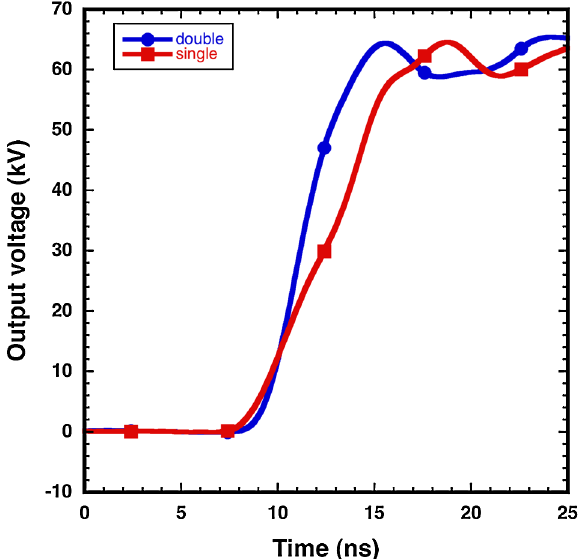
FIG. 11. (Color) Output voltage with normal two-channel op- eration, and with the laser focal point adjusted so that one side of the switch closes later than the other, so that 95% of the current flows on one side, effectively acting as a single channel switch. As expected, the rise time is shorter by nearly a factor of 2 with both channels. The shunt capacity of the nominally unused switch half in the single channel case may act to compensate the channel inductance and raise the output voltage above the level of a conventional single-sided switch. The tests were done at 77 kV DC charge.